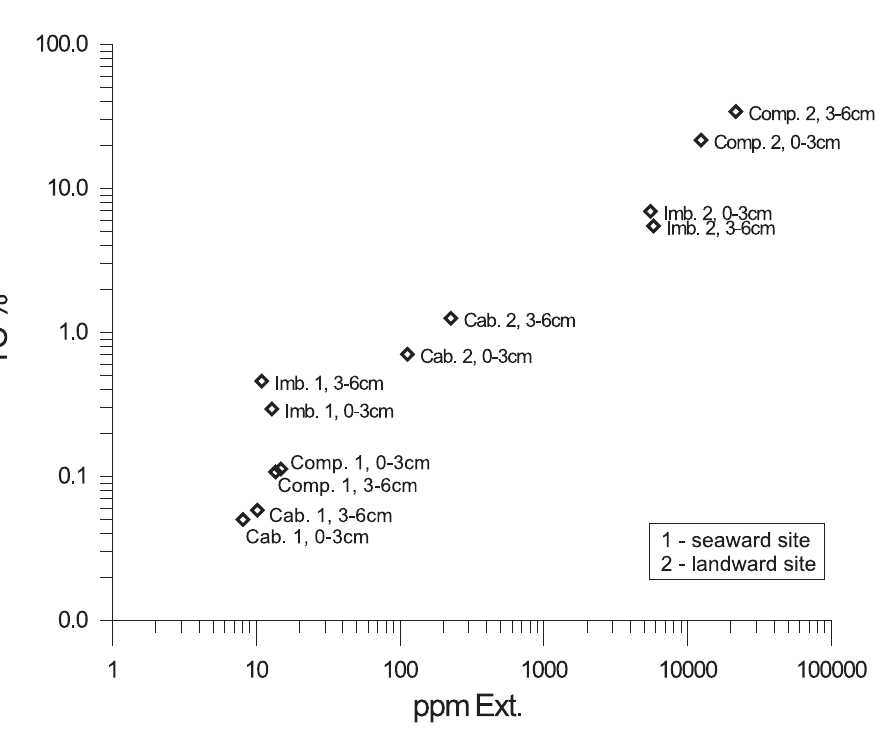
Fig. 2 – Crossplot of total carbon (% dw) versus dichloromethane-extractable organic matter